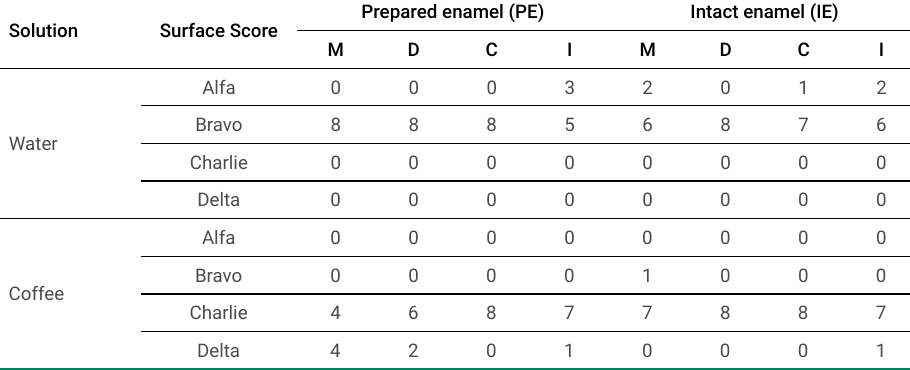
Table 1. Surface score distribution for prepared and intact enamel restored with ceramic veneers, immersed in water and coffee solution Solution